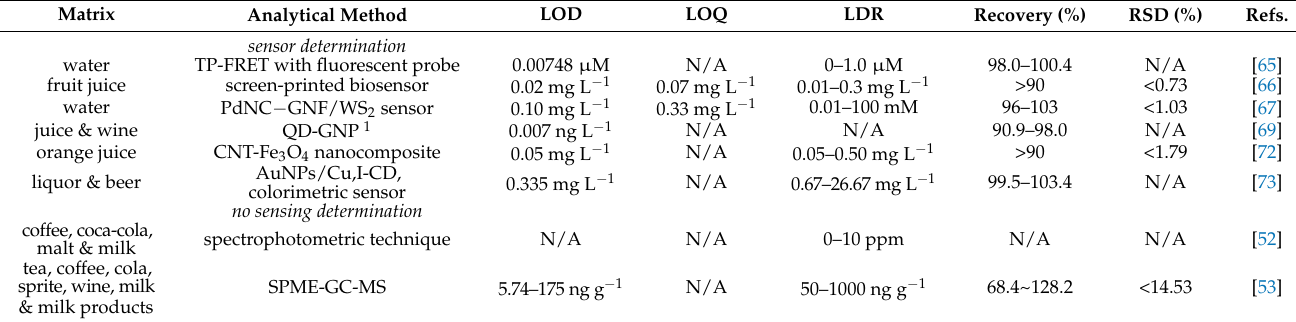
Table 5. Analytical performance of sensing and no-sensing determinations applied to (alcoholic and non-alcoholic) beverage matrix. The term “N/A” means the information is absent in the